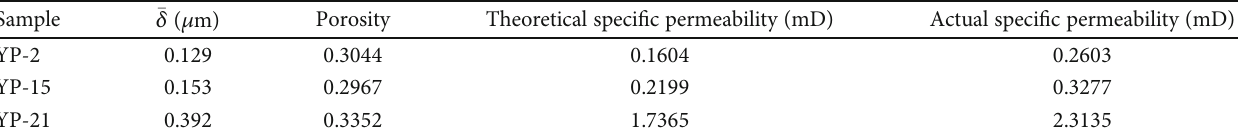
Table 10: Theoretical and actual speci fi c permeability of samples in the seepage mutation stage. Sample